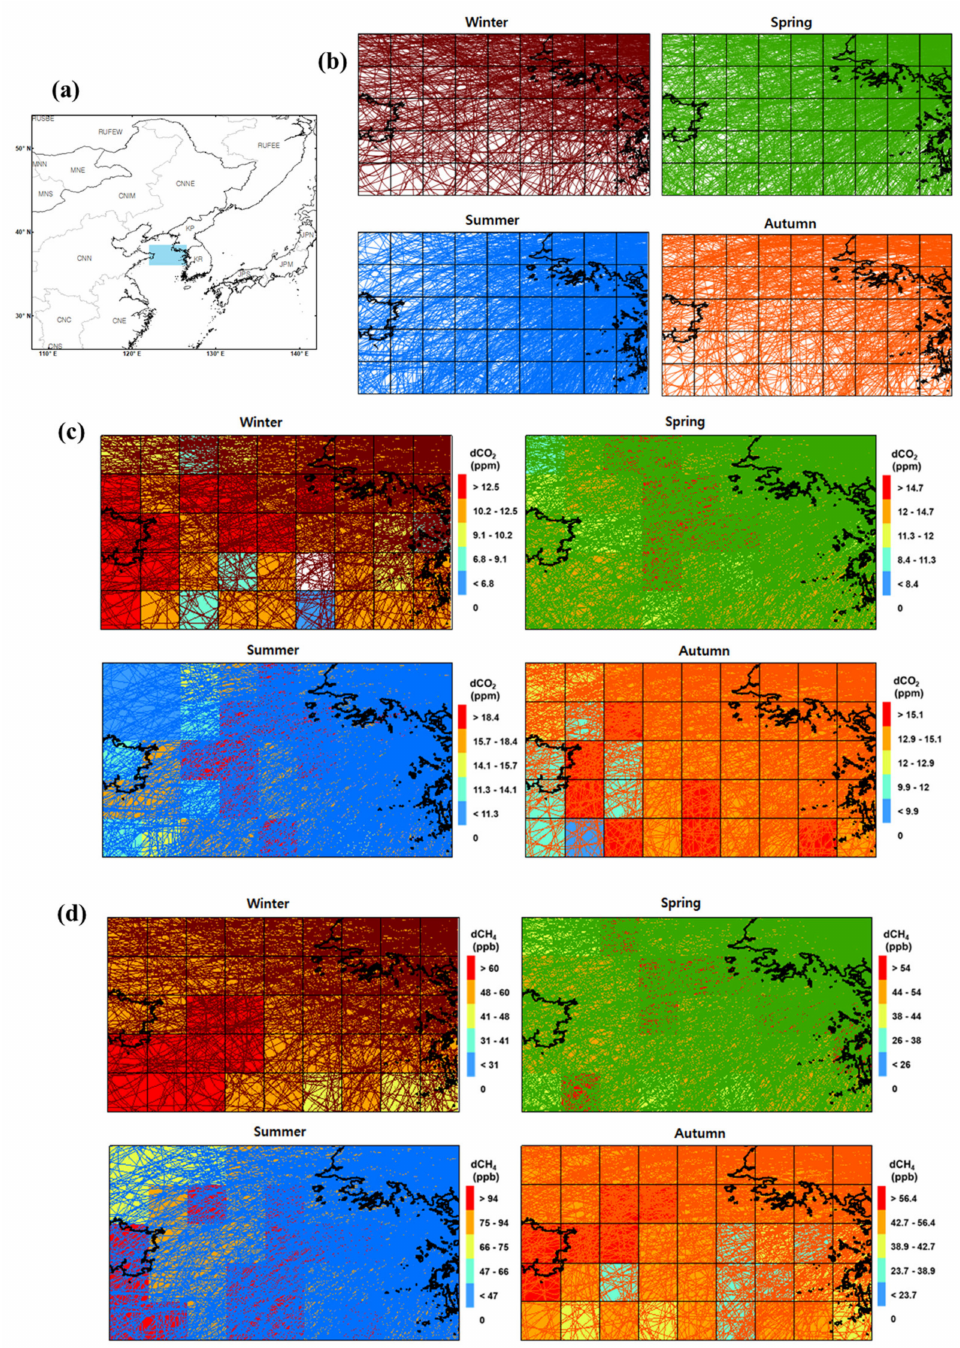
Figure A4. ( a ) A map indicating areas of interest (AOI) (here, some Yellow Sea areas) in which the patterns of air mass trajectories are curious, ( b ) seasonal air mass trajectories in the grid cells over the selected Yellow Sea areas (i.e., AOI), ( c ) Air mass trajectories superimposed over the CO 2 source distribution derived by CWT analysis in some Yellow Sea areas in each season and ( d ) Air mass trajectories superimposed over the CH 4 source distribution derived by CWT analysis in some Yellow Sea areas in each